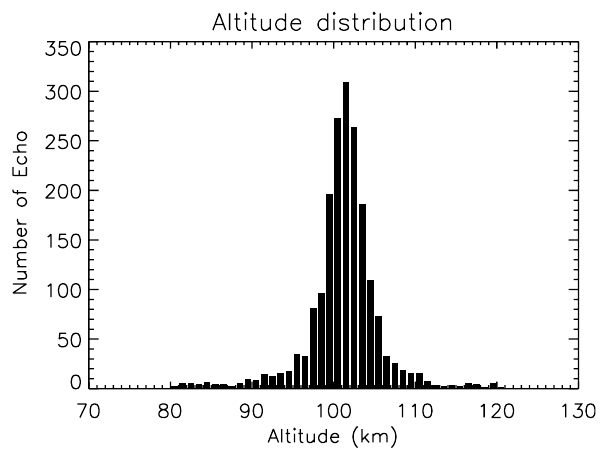
Fig. 7. Histogram of true height distribution of echoes by the LTPR at 2300–2400 JST, 3 August